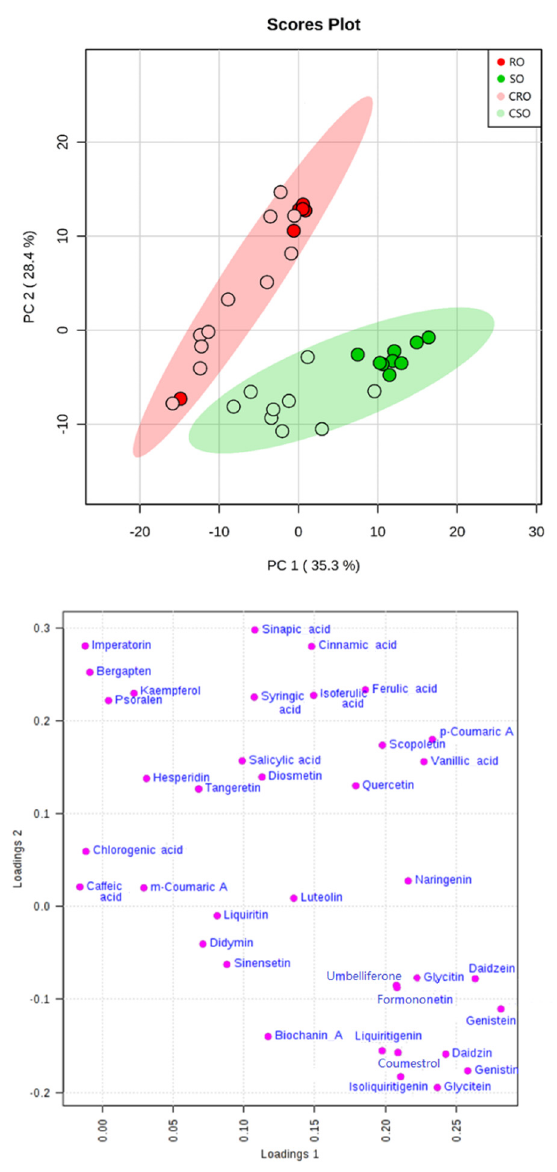
Figure 1. Principal component analysis (PCA) score plot and loading plot of soybean oils and rapeseed oils (RO, Rapeseed oil; CRO, Commercial rapeseed oil; SO, Soybean oil; CSO, Commercial soybean oil).